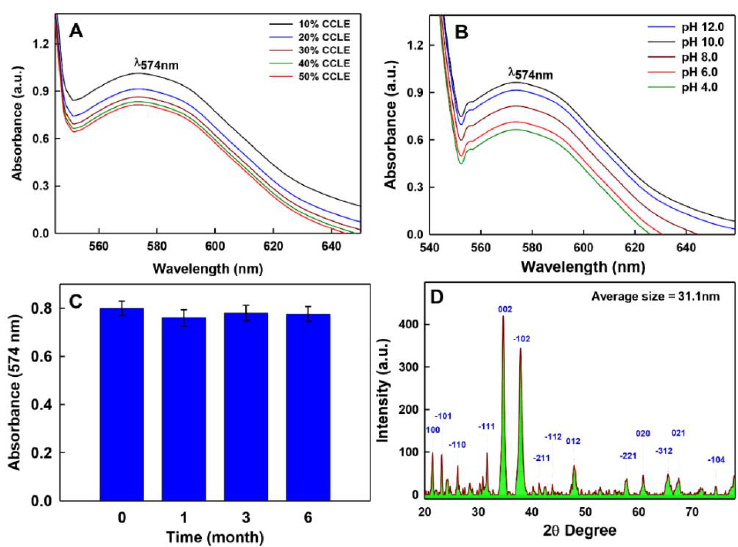
Figure 1. Graphical representation of CLE-CuONPs synthesis.